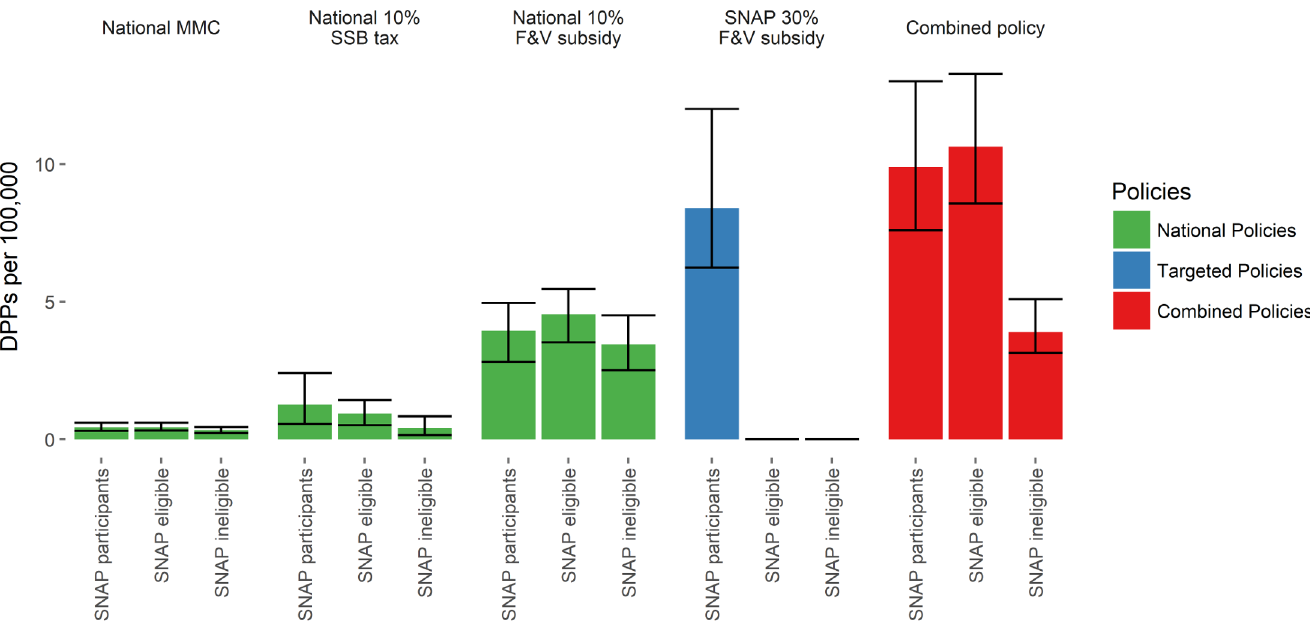
Fig 2. Deaths prevented or postponed per 100,000population for each policy modelled in 1 y—2030—bySNAP group. Error bars indicate 95% uncertaintyintervals. DPPs, deaths prevented or postponed;F&V, fruit and vegetable; MMC, mass media campaign;SNAP, SupplementalNutrition Assistance Program; SSB, sugar-sweetened